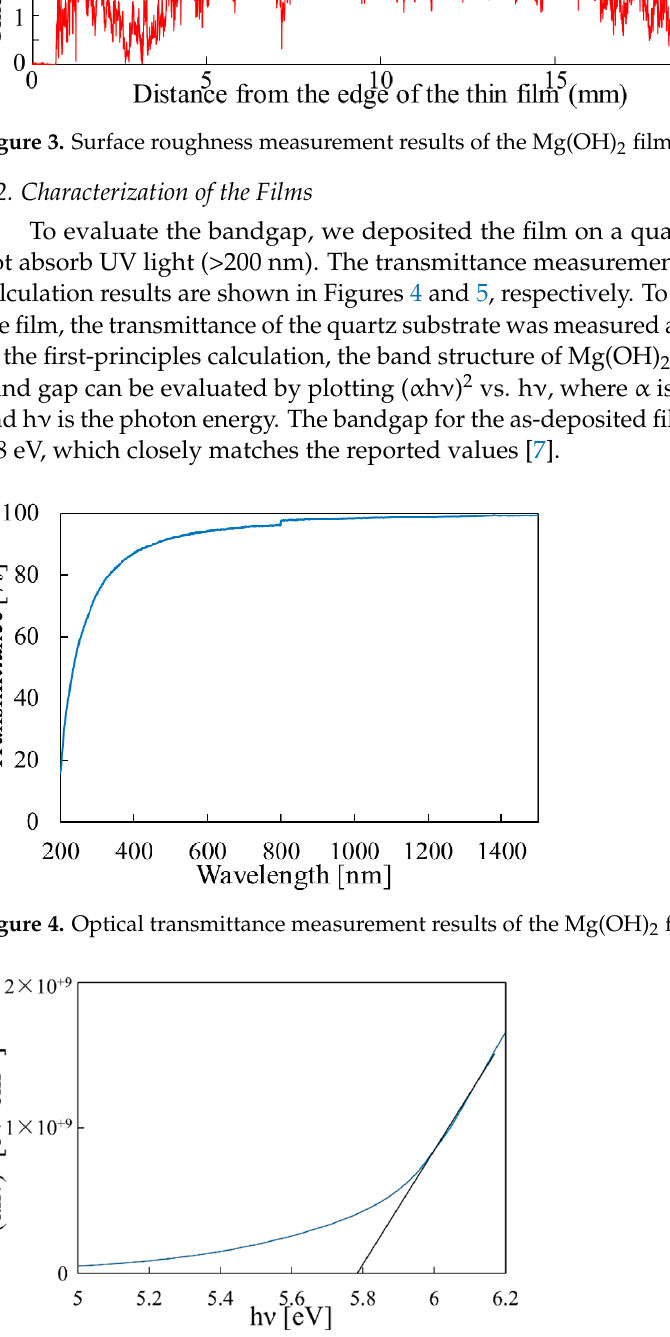
Figure 2. Optical transmittance under each deposition condition: ( a ) change in the number of dep- ositions; ( b ) change in Mg(NO 3 ) 2 concentration; ( c ) change in NaOH concentration. (The steps near 800 nm were caused by sensor changes in the spectrophotometer, and we failed to calibrate the signal level.) Figure 3. Surface roughness measurement results of the Mg(OH) 2 film. Figure 3. Surface roughness measurement results of the Mg(OH) 2 film.